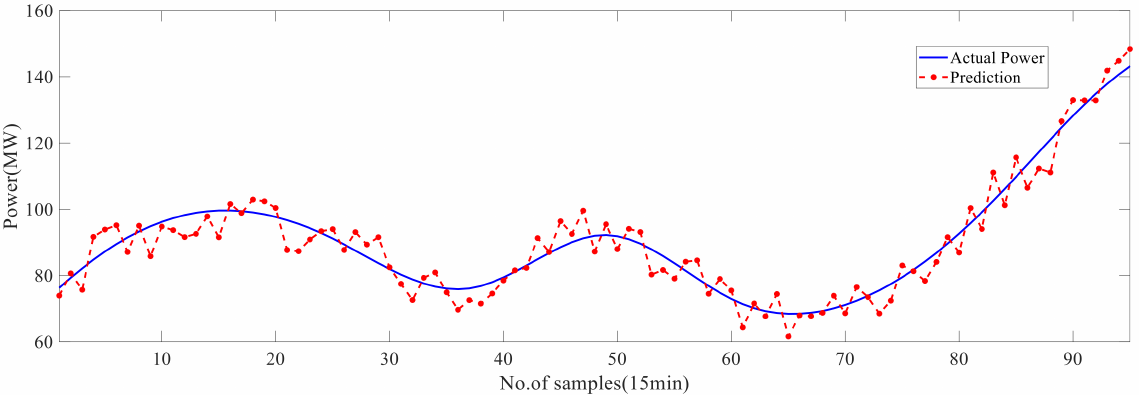
Figure 6. Actual and forecasted output power of wind plant for a spring